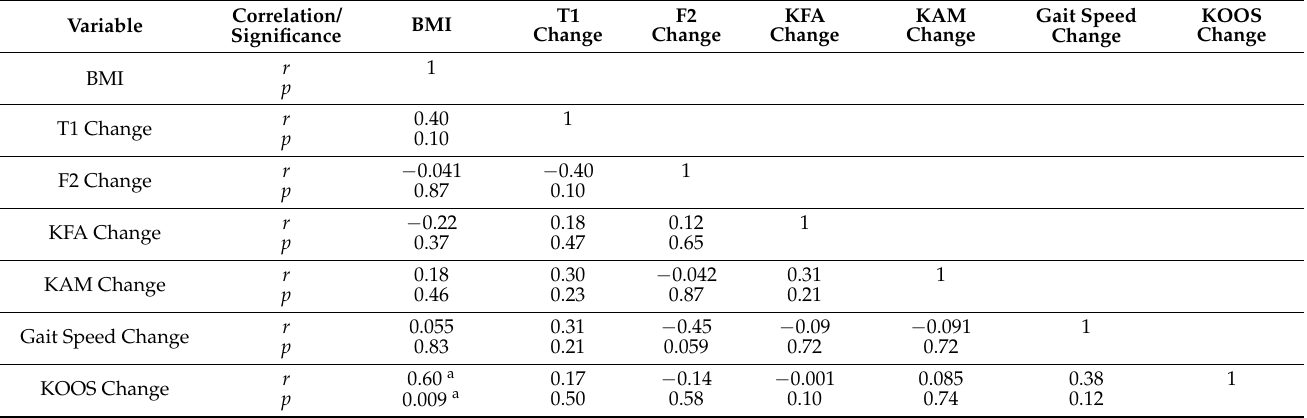
Table 4. Correlations between body mass index and amount of change in dependent